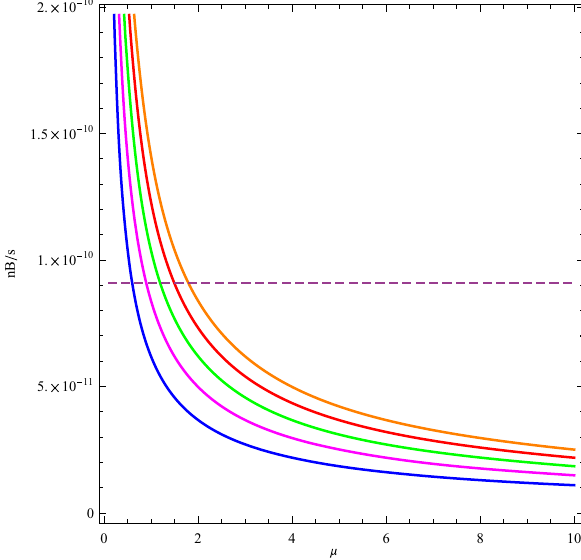
Fig. 3 The γ - dependence of baryon to entropy ratio for the model f ( R , T ) = R + μ R 2 + λ T for M ∗ = 10 12 GeV, T D = 2 × 10 16 GeV. The curves are plotted for λ = 10 5 and for μ = 10 − 5 (blue), μ = 2 × 10 − 5 (magenta), μ = 3 × 10 − 5 (green), μ = 4 × 10 − 5 (red), μ = 5 × 10 − 10 (orange) and dashed, the observational value